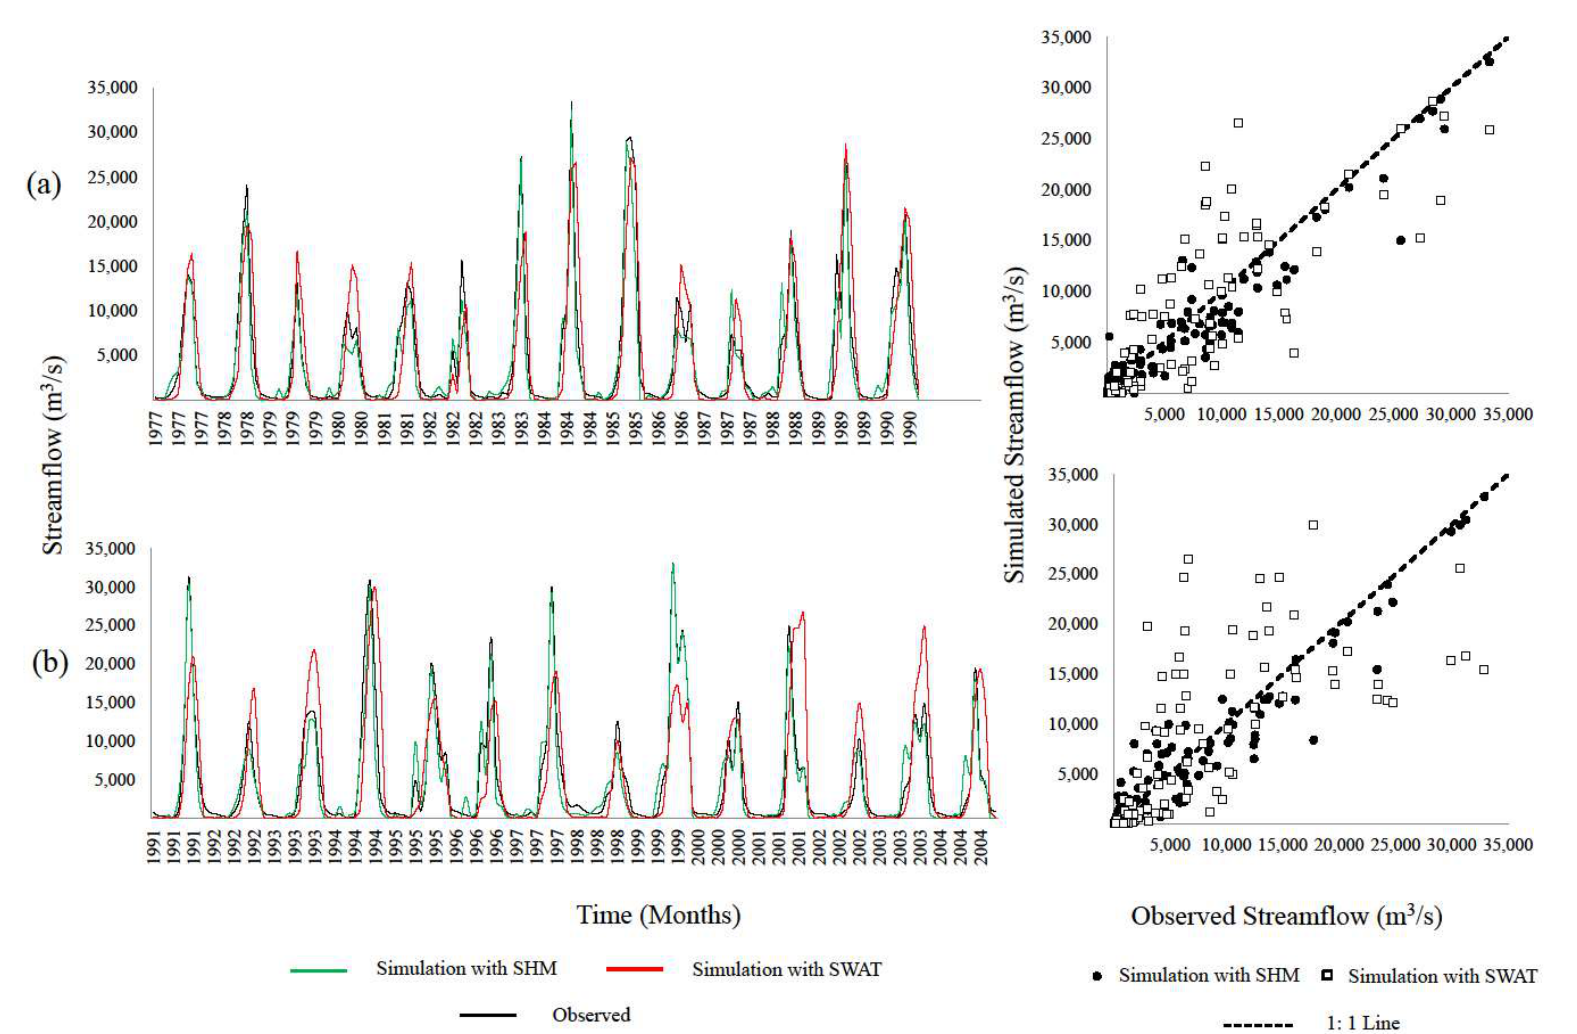
Figure 2. Comparison between observed and simulated monthly streamflow hydrographs and scatter plots during ( a ) calibration and ( b ) validation periods.